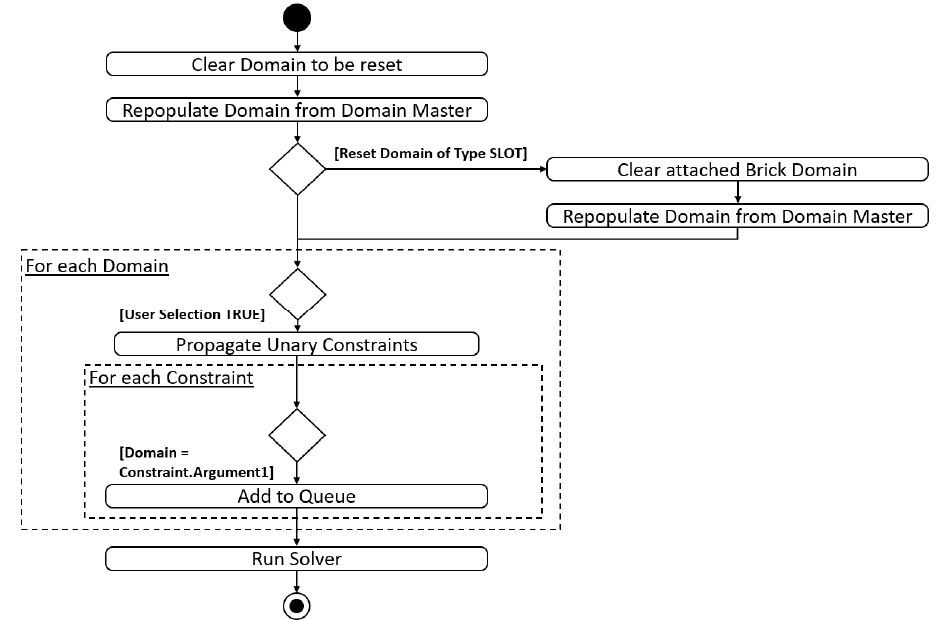
Figure 12. Activity diagram for relaxing constraints and update.